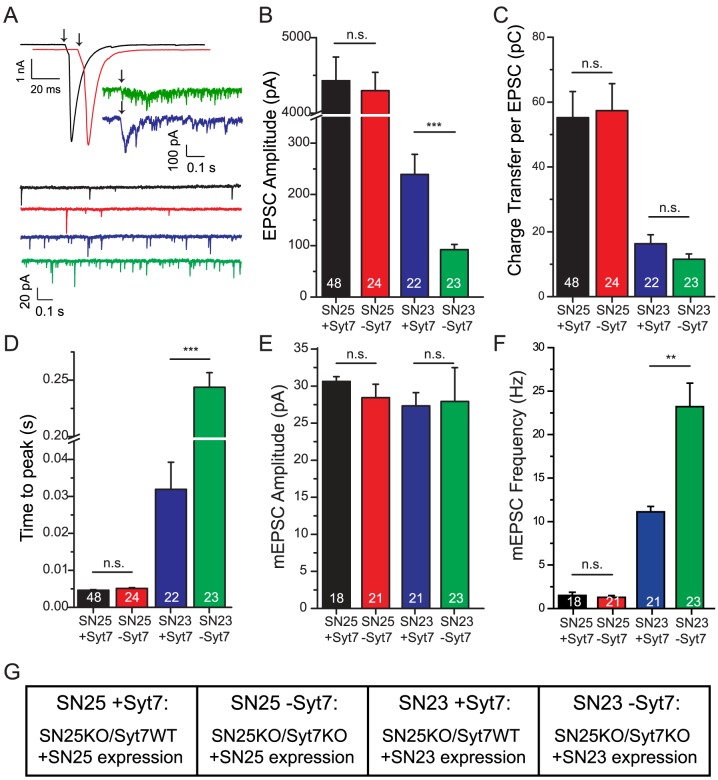
Expression of SNAP-23 in SNAP-25 KO neurons leads to asynchronous release, which is exacerbated by deletion of Synaptotagmin-7.A, top: Representative EPSC traces of SNAP-25 KO neurons rescued with SNAP-25 (black) or SNAP-23 (blue) and SNAP-25/Syt-7 DKO neurons rescued with SNAP-25 (red), or SNAP-23 (green). Stimulation is indicated by an arrow. A, bottom: Representative mEPSC traces of SNAP-25 KO neurons rescued with SNAP-25 (black) or SNAP-23 (blue) and SNAP-25/Syt-7 DKO neurons rescued with SNAP-25 (red), or SNAP-23 (green). B: Expression of SNAP-23 in SNAP-25 KO neurons (blue) led to reduced peak EPSC amplitudes in SNAP-25 KO neurons, which were further significantly reduced in the absence of Syt-7 (green). In contrast, syt-7 deletion (red: SNAP-25 expression in SNAP-25/Syt-7 DKO neuron) was without consequence in the presence of SNAP-25 (black: SNAP-25 expression in SNAP-25 KO neuron). C: SNAP-23 rescued neurons displayed a 3–4 fold reduction in the charge transferred upon a stimulus; this reduction was independent of Syt-7 expression. D: The time-to-peak (EPSC) was prolonged in SNAP-23-rescued SNAP-25 KO neurons. Additional deletion of Syt-7 leads to a total of 50-fold increase in the time-to-peak. E: Spontaneous mEPSC amplitudes were unchanged in all four conditions. F: The frequency of mEPSCs was increased when SNAP-23 was expressed in SNAP-25 KO neurons, and further significantly increased when SNAP-23 was expressed in the SNAP-25/Syt-7 double KO background. G: Explanation of abbreviated labeling, used in Fig. 2–5. * = p<0.05; ** = p<0.01; *** = p<0.001.